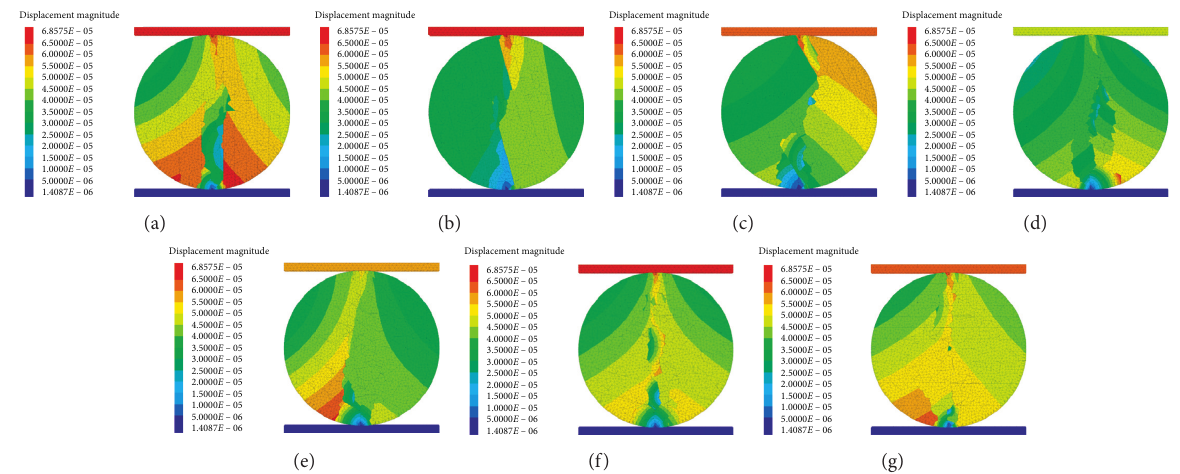
Figure 11: Cloud diagrams of loading displacement with uneven parallel bedding model at different angles. (a) 0 ° . (b) 15 ° . (c) 30 ° . (d) 45 ° . (e) 60 ° . (f) 75 ° . (g) 90 ° .